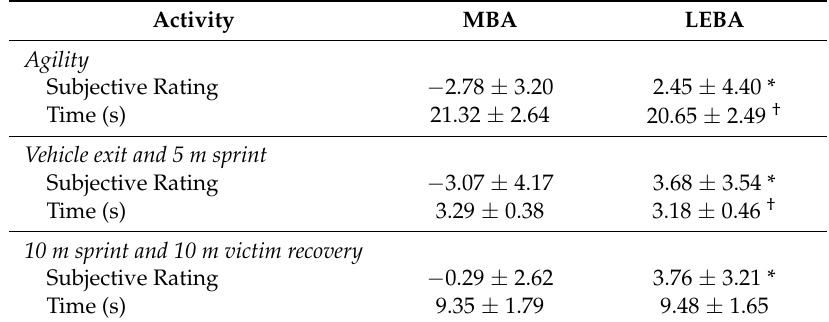
Table 5. Task Performance and subjective results (mean ± SD) for the different body armour